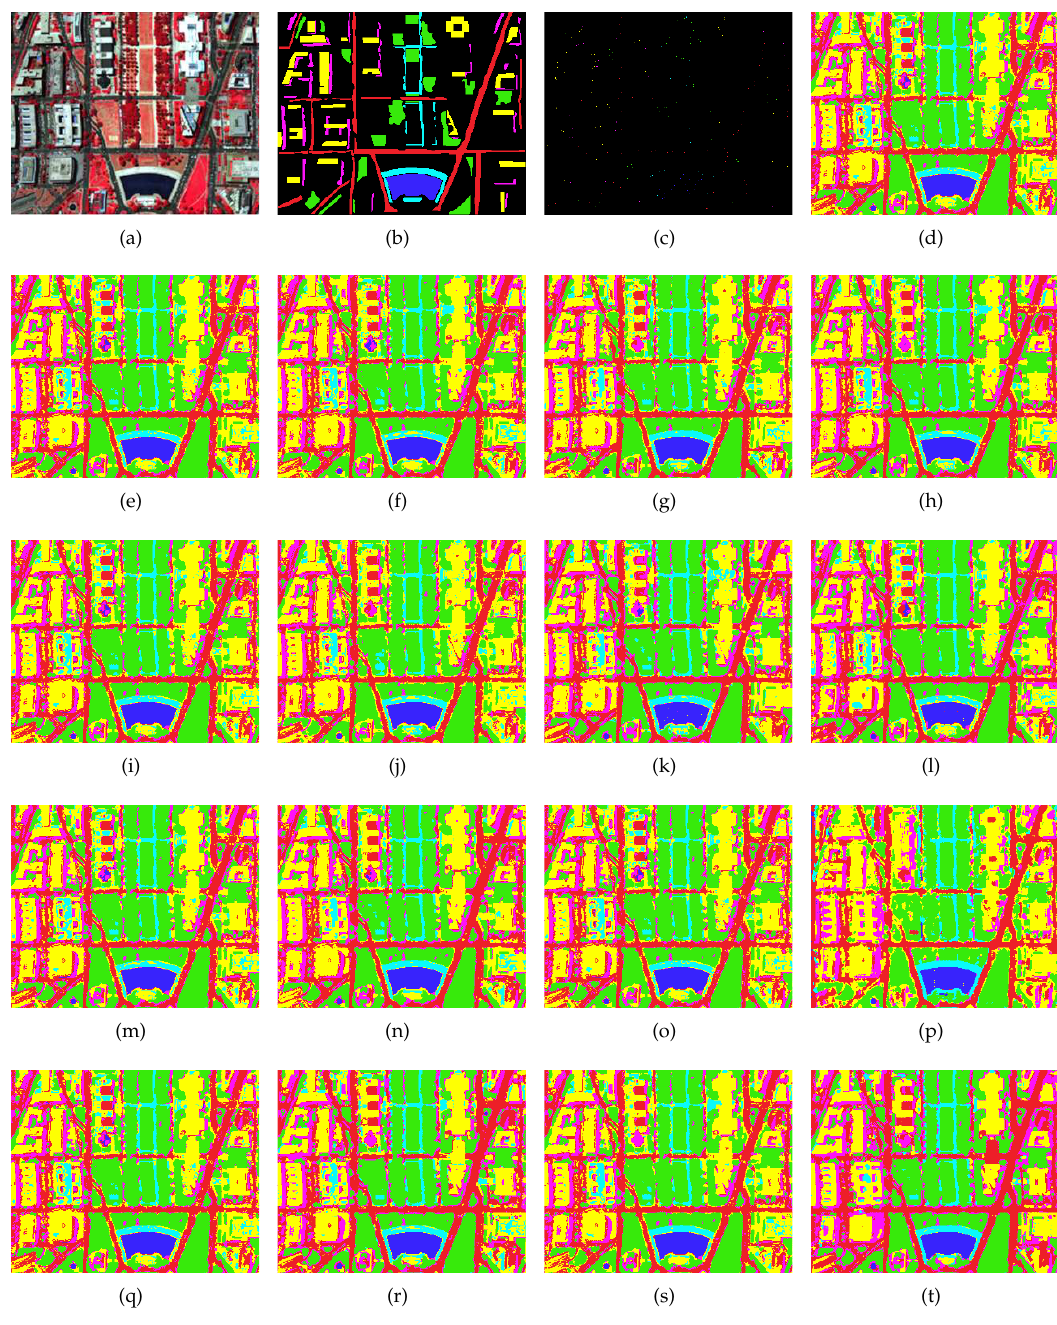
Figure 10. Classification maps of different methods on the Washington DC Mall data set. ( a ) False color image; ( b ) Ground truth; ( c ) Training samples; ( d ) RAW; ( e ) PCA; ( f ) NPE; ( g ) LPP; ( h ) LDA; ( i ) MMC; ( j ) MFA; ( k ) NWFE; ( l ) SPP; ( m ) SDE; ( n ) SME; ( o ) SMML; ( p ) MMDA; ( q ) DSSM; ( r ) LPNPE; ( s ) WSSGLDA; ( t )